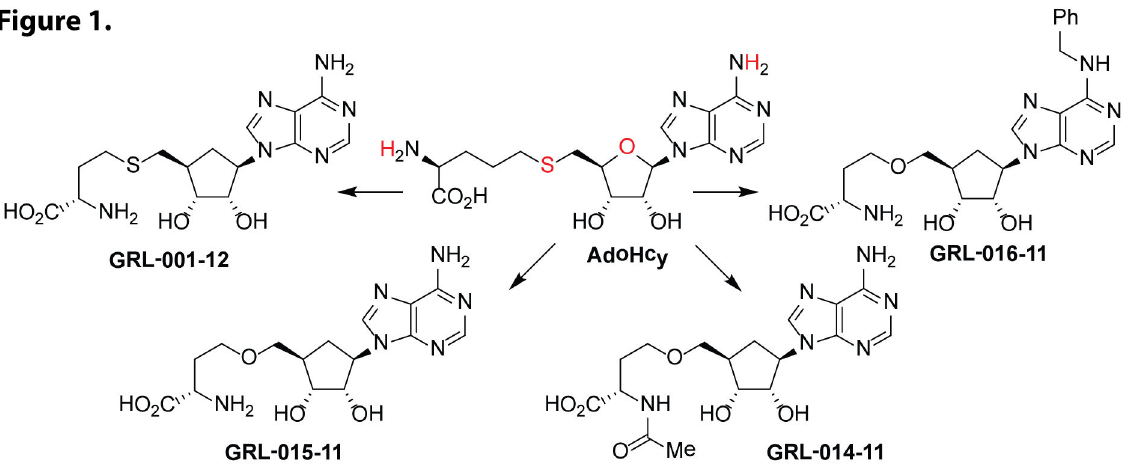
Figure 1. Chemical structures of AdoHcy and its four derivatives synthesized. Groups of AdoHcy that were modified were in red